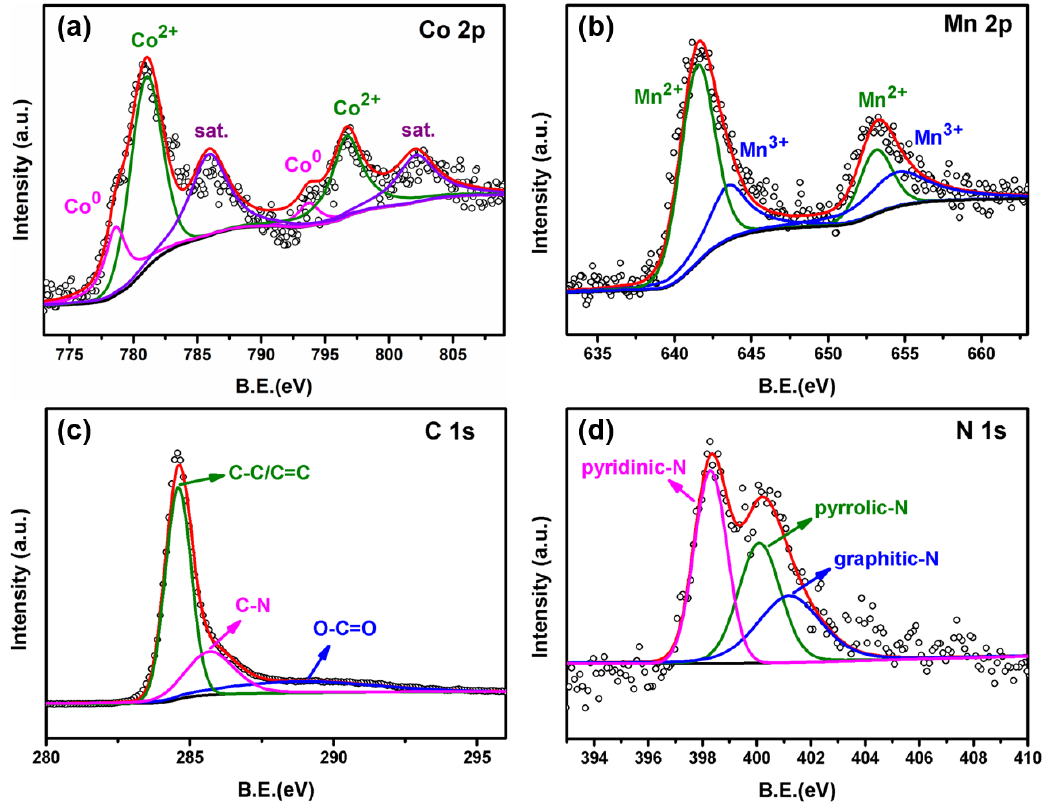
Figure 4. XPS spectra of S-600: ( a ) Co 2p, ( b ) Mn 2p, ( c ) C 1s, and ( d ) N 1s.